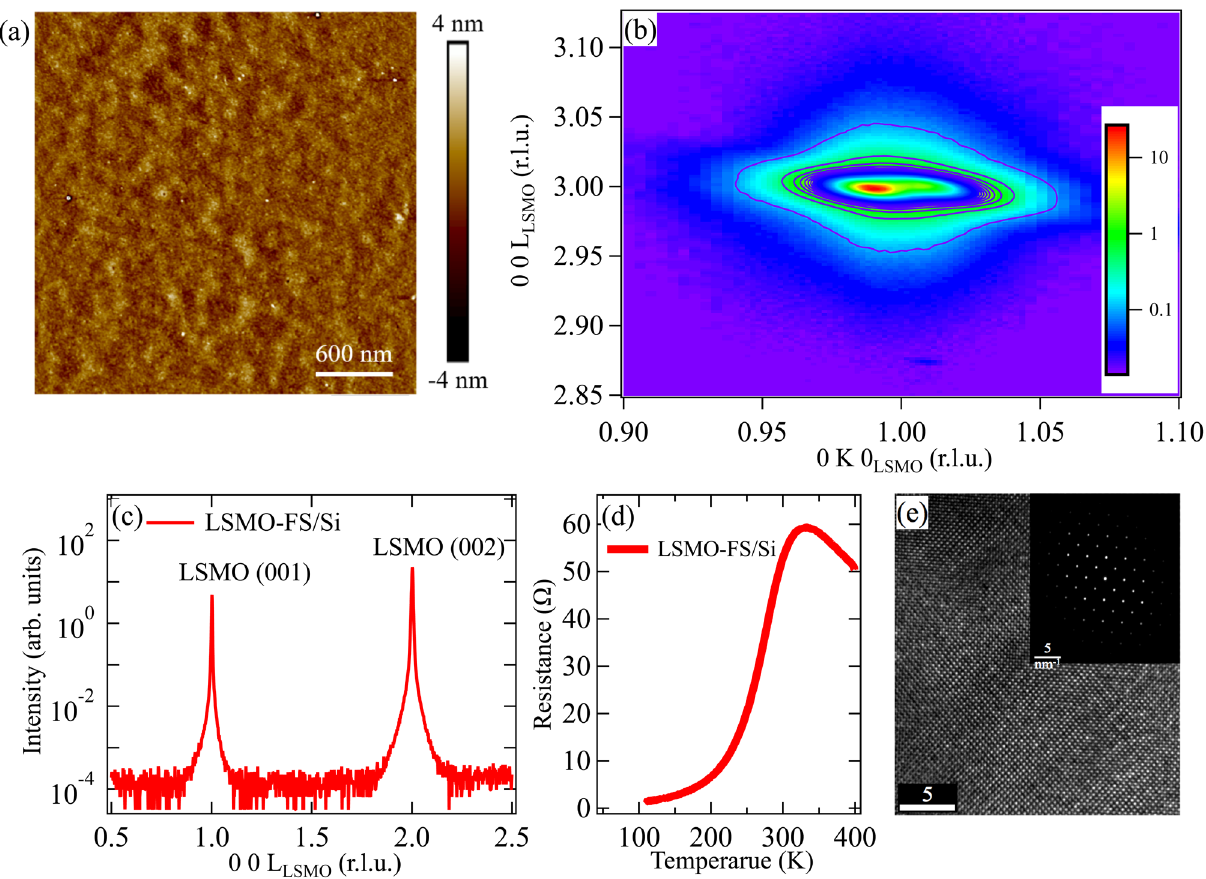
Figure 2. Characterization of the freestanding LSMO thin film on Si substrate (LSMO-FS/Si). ( a ) Surface morphology from AFM. ( b ) The reciprocal space mapping around (013) diffraction peak. ( c ) XRD θ-2θ scan along the (00L) direction. ( d ) The resistance curve obtained by four-point method. ( e ) TEM image. The inset shows the electron